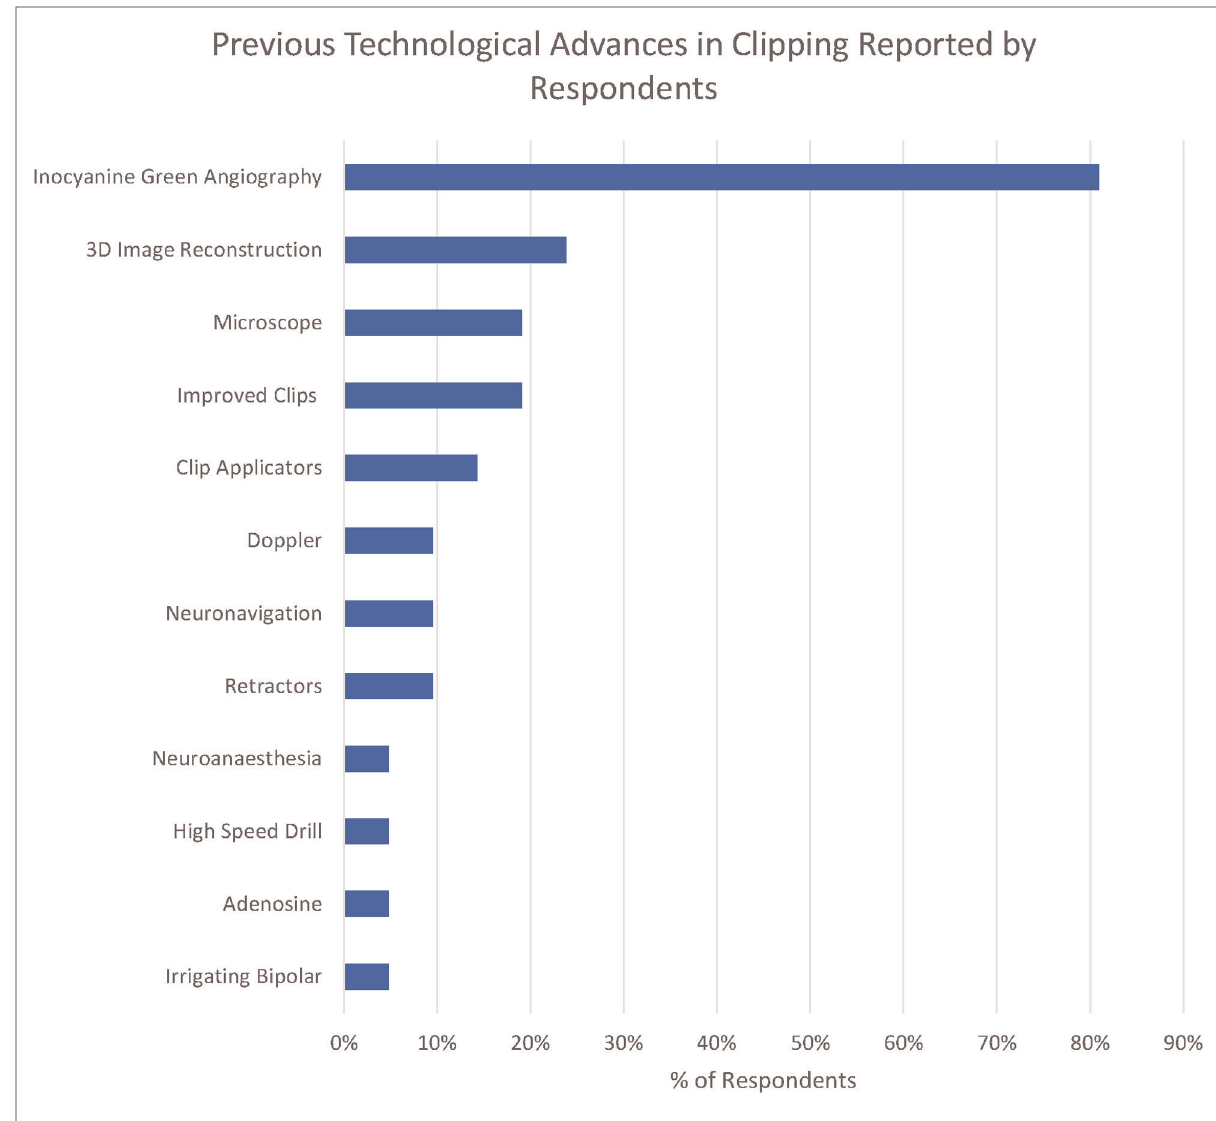
FIGURE 4 Previous technological advances in clipping reported by